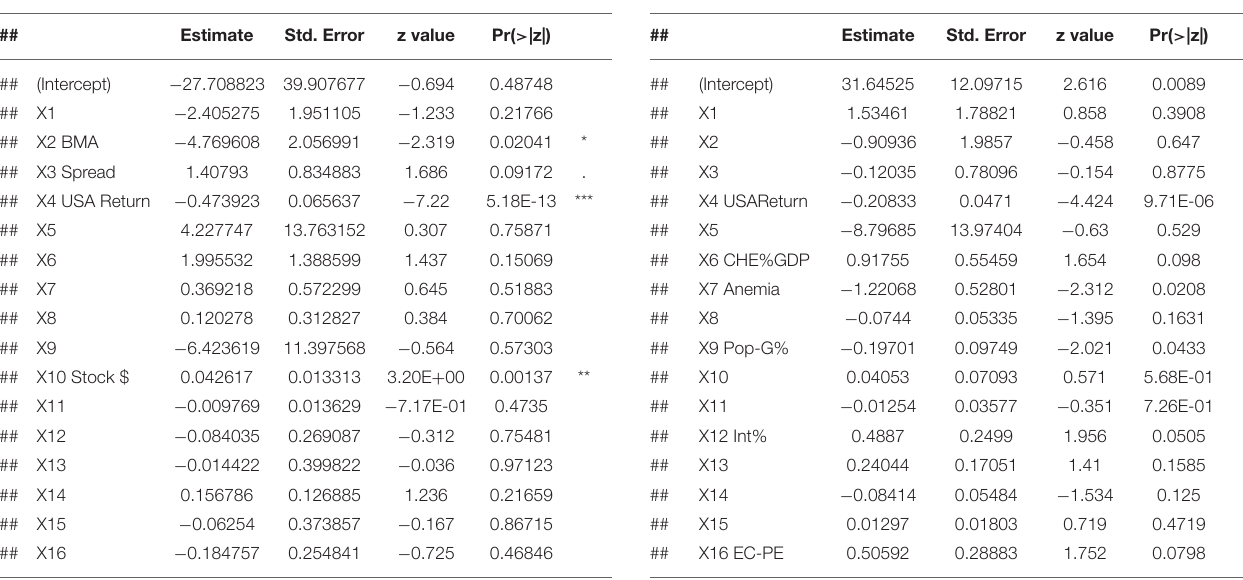
TABLE 9 | Logistic regression results in India.